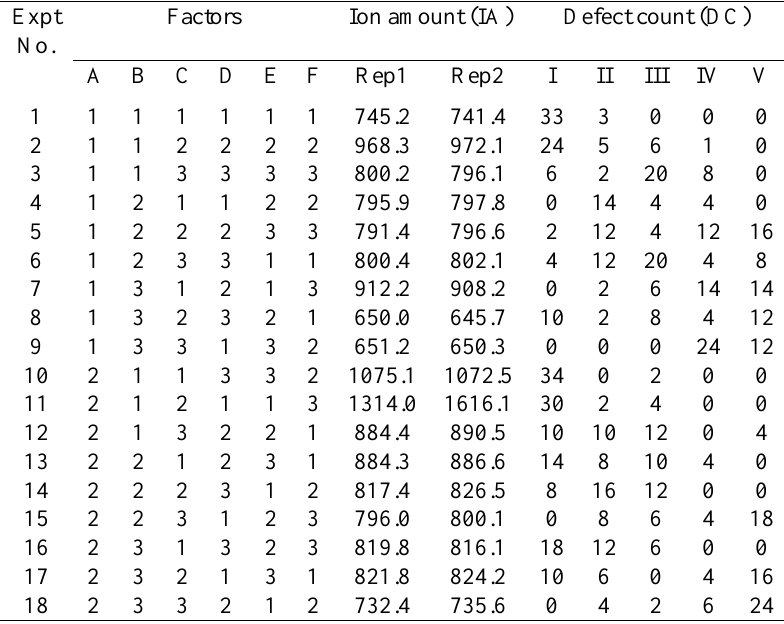
Table 5. Experimental data on ion implantation process